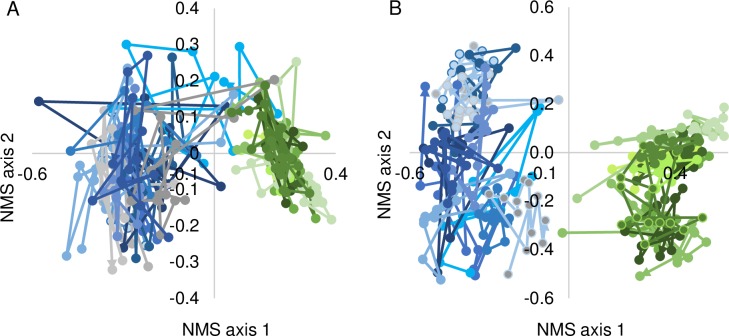
Non-metric multidimensional scaling (NMS) graph by (A) functional group and (B) species of plant community composition in adjacent ex-arable fields (blue and grey colors) and never-tilled fields (green colors) over 13 years. Each point represents the mean composition of vegetation across a transect located 50 m from a tillage boundary. Lines connect values from a field over 13 years of direct observation. For clarity, data from 12 of 25 randomly selected sites are shown.